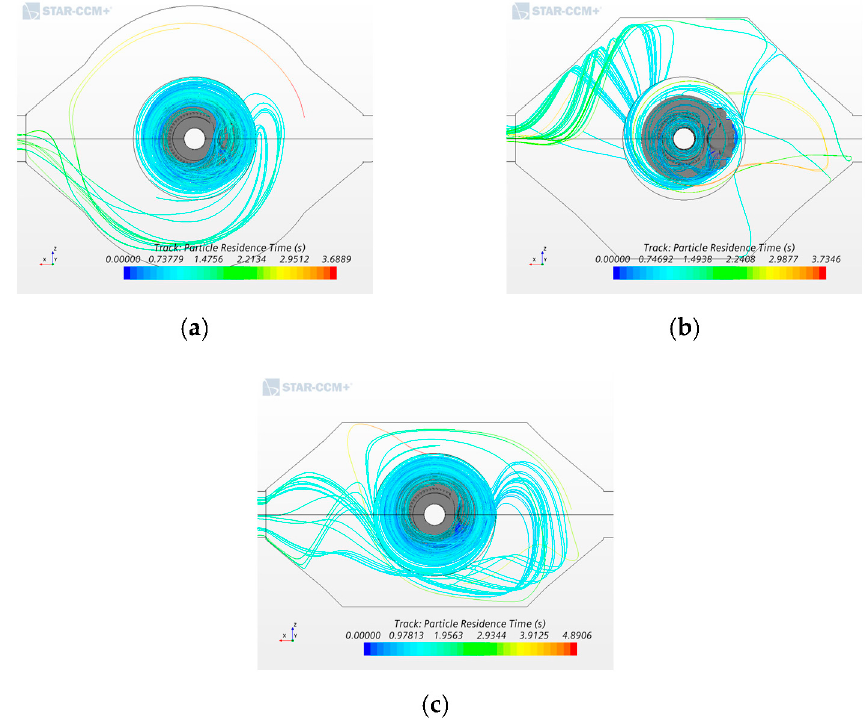
Figure 6. Particle residence time: ( a ) circular design; ( b ) hexagonal design; ( c ) rectangular design.